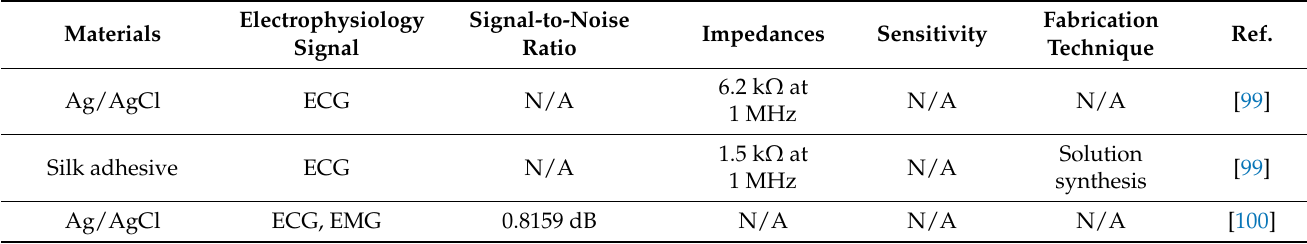
Table 1. Comparison of sensing properties according to fabrication technique with commercial Ag/AgCl